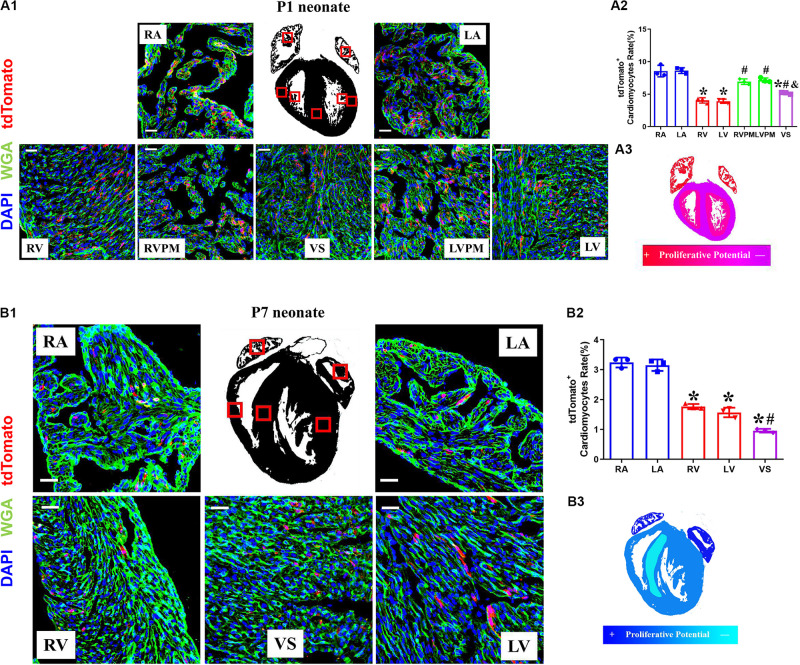
The variant proliferation potential during early postnatal development. (A) Representative images (A1) and quantification (A2) of immunostaining for tdTomato with wheat germ agglutinin (WGA) staining on P1 Tnnt2-Dre × Aurkb-rox-tdTomato heart sections in different regions, RA, right atrium; LA, left atrium; RV, right ventricle; LV, left ventricle; RVPM, right ventricular papillary muscle; LVPM, left ventricular papillary muscle; VS, ventricular septum. Scale bar = 40 μm, n = 3, *p < 0.05 vs. atrium; #p < 0.05 vs. ventricular; &p < 0.05 vs. ventricular papillary muscle. (A3) Schematic figure showing variant cytokinesis capacity on P1 Tnnt2-Dre × Aurkb-rox-tdTomato heart sections in different regions. (B) Representative images (B1) and quantification (B2) of immunostaining for tdTomato with WGA staining on P7 Tnnt2-Dre × Aurkb-rox-tdTomato heart sections in different regions, RA, right atrium; LA, left atrium; RV, right ventricle; LV, left ventricle; VS, ventricular septum. Scale bar = 40 μm, n = 3, *p < 0.05 vs. atrium; #p < 0.05 vs. ventricular. (B3) Schematic figure showing variant cytokinesis capacity on P7 Tnnt2-Dre × Aurkb-rox-tdTomato heart sections in different regions.